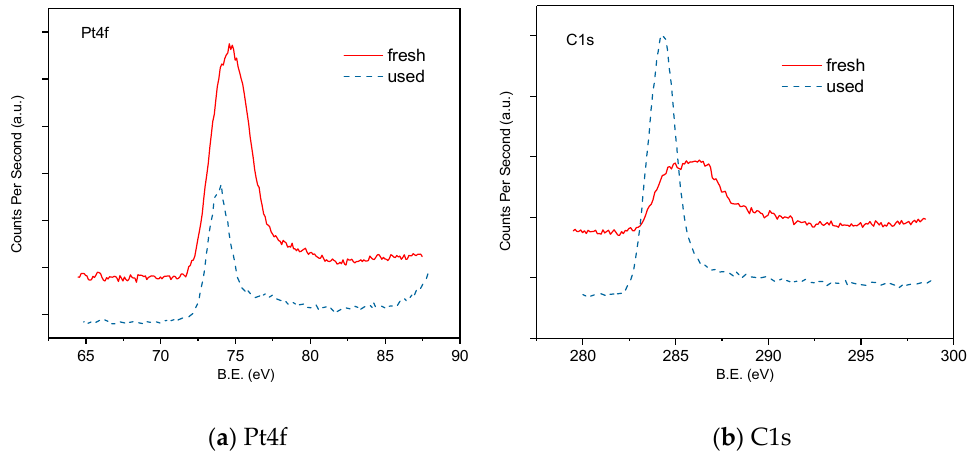
Figure 11. XPS patterns of Pt4f and C1s photoemission spectra of the of Pt / Rh TWC catalysts.